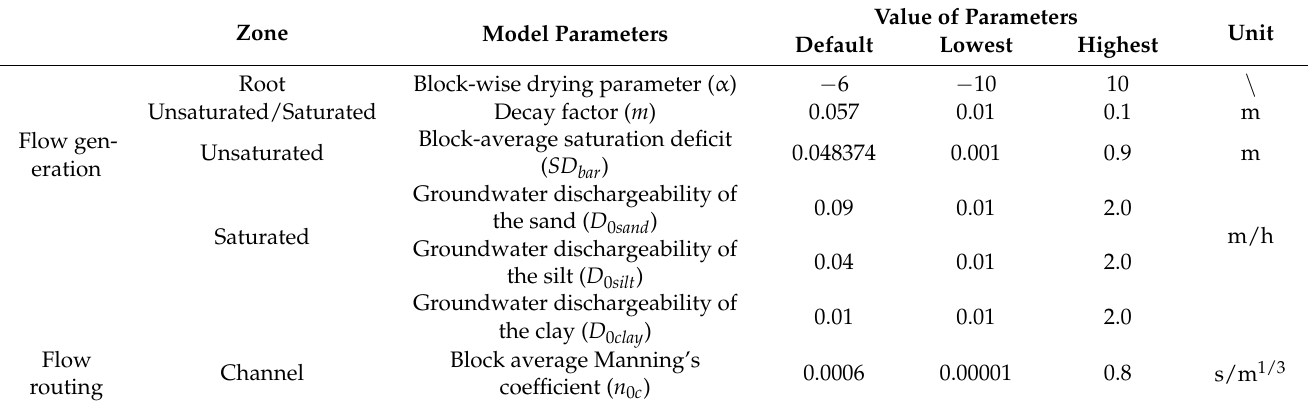
Table 1. Model parameters of